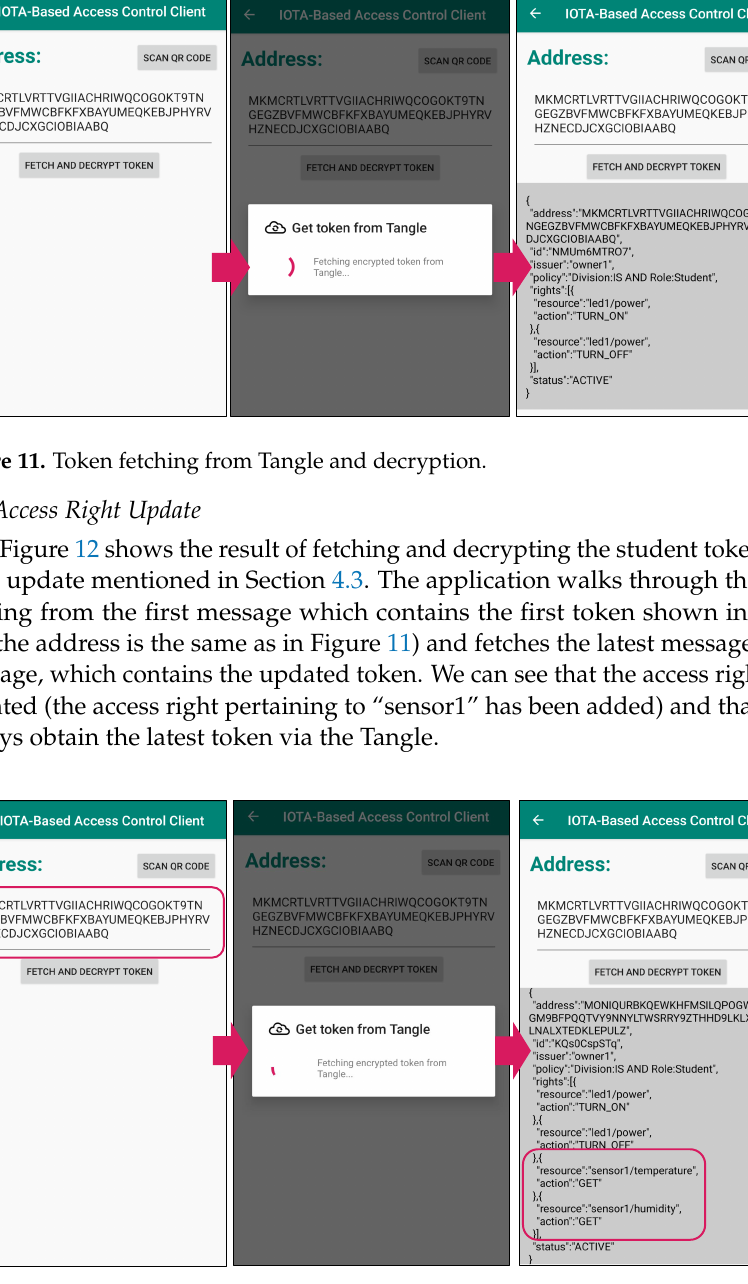
Figure 12. Token fetching from Tangle and decryption after access right